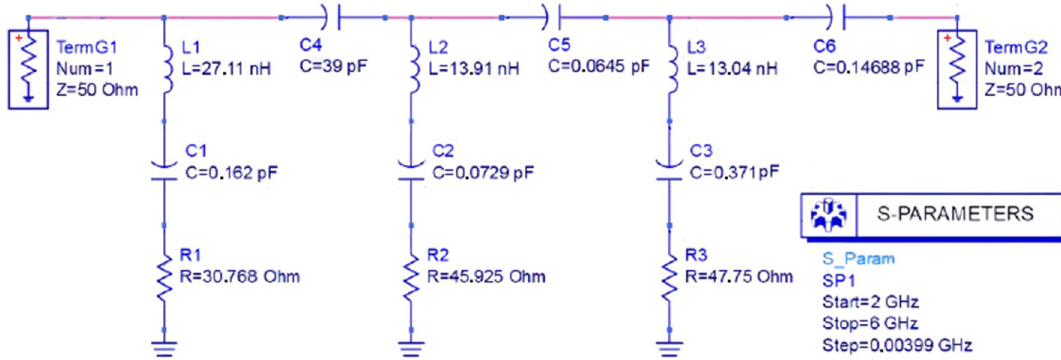
Figure 4. Equivalent circuit of the absorber unit